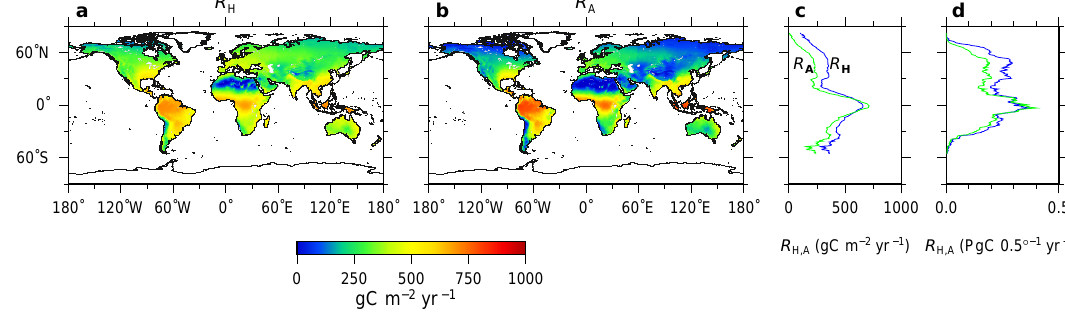
Figure 7. Spatial distribution of heterotrophic respiration (a) and autotrophic respiration (b) . (c) and (d) depict the latitudinal distributions of heterotrophic and autotrophic respiration per square meter and per 0.5 ◦ , respectively.